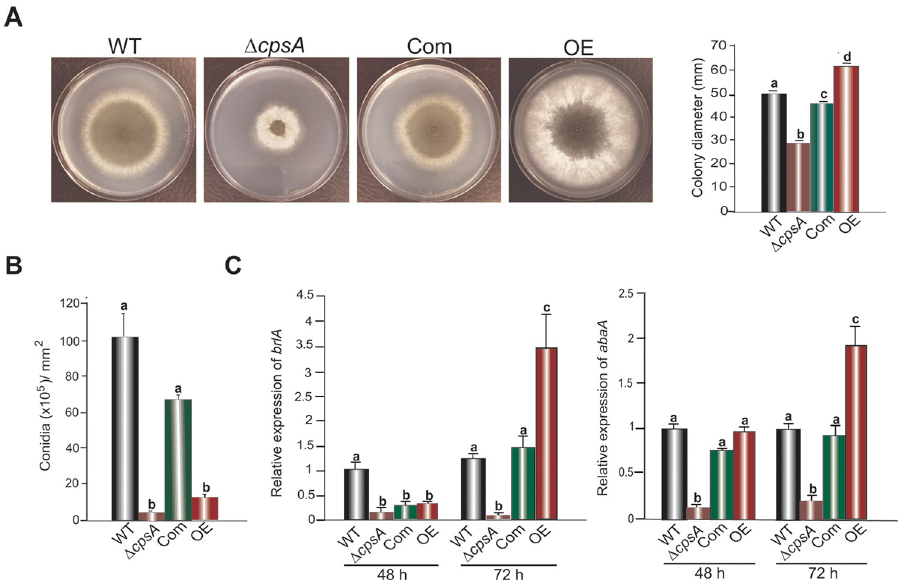
Fig 2. cpsA influences growth and conidiation in A . fumigatus . (A) Point-inoculated cultures of A . fumigatus wild type, Δ cpsA , Com and OE strains. Plates were incubated at 37˚C for 48 h. On right, measurement of colony diameter. (B) Conidial quantification of A . fumigatus wild type, Δ cpsA , Com and OE top-agar inoculated cultures grown at 37˚C for 72 h. (C) Gene expression analysis of brlA and abaA using qRT-PCR from mycelia collected from liquid stationary cultures incubated in the dark for 48 h and 72 h. The relative expression was calculated using 2 - ΔΔ CT method as described by Livak and Schmittgen [28]. Values were normalized to the expression level of WT at 48 h. The error bar represents the normalized standard